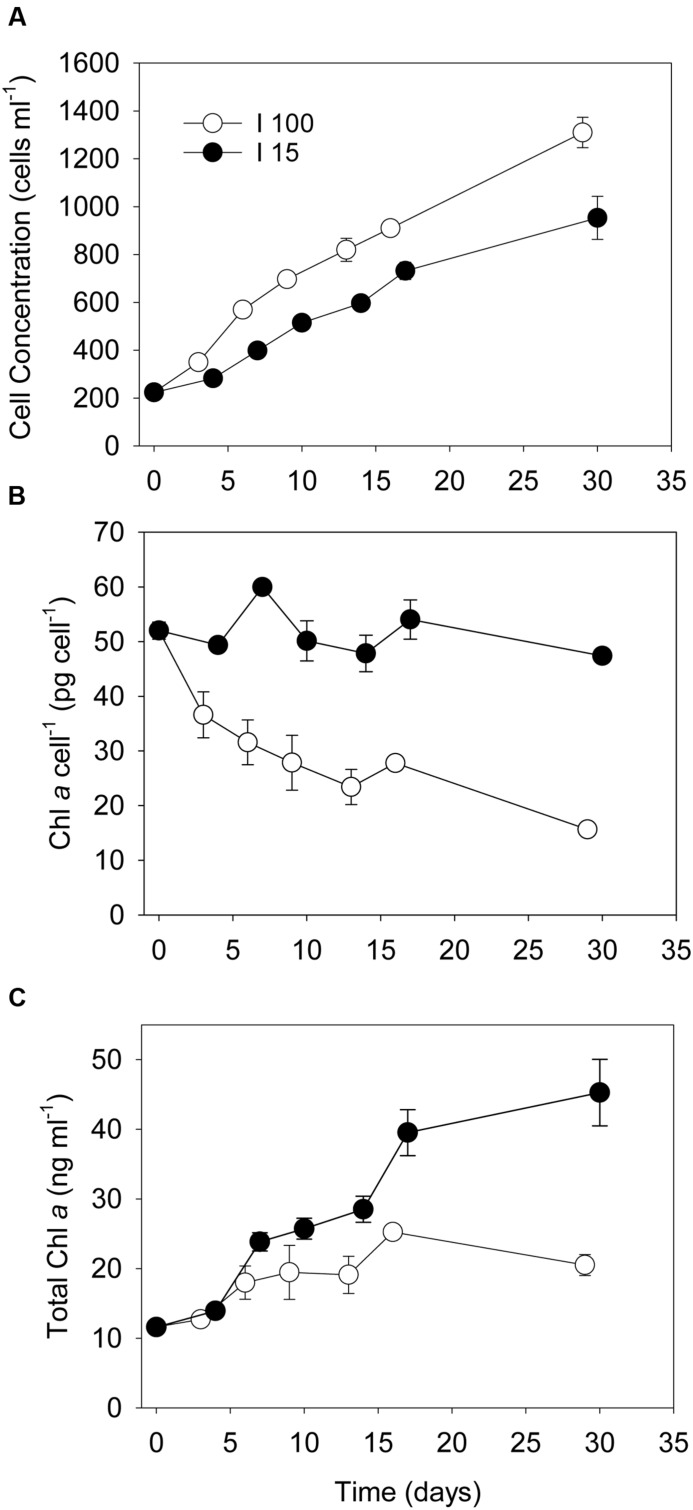
Developments in Dinophysis acuta cell concentrations, cellular Chl a content and total Chl a concentrations when subjected to prey starvation at the start of the experiment and incubated for 1 month under an irradiance of (o) 100 μmol photons m-2 s-1 (I100) and (●) 15 μmol photons m-2 s-1 (I15), respectively.
(A) cell concentration (cells ml-1), (B) cellular Chl a concentration (pg Chl a cell-1), (C) total Chl a concentration (ng Chl a ml-1). Data points represent treatment means and error bars indicate standard errors (n = 3).